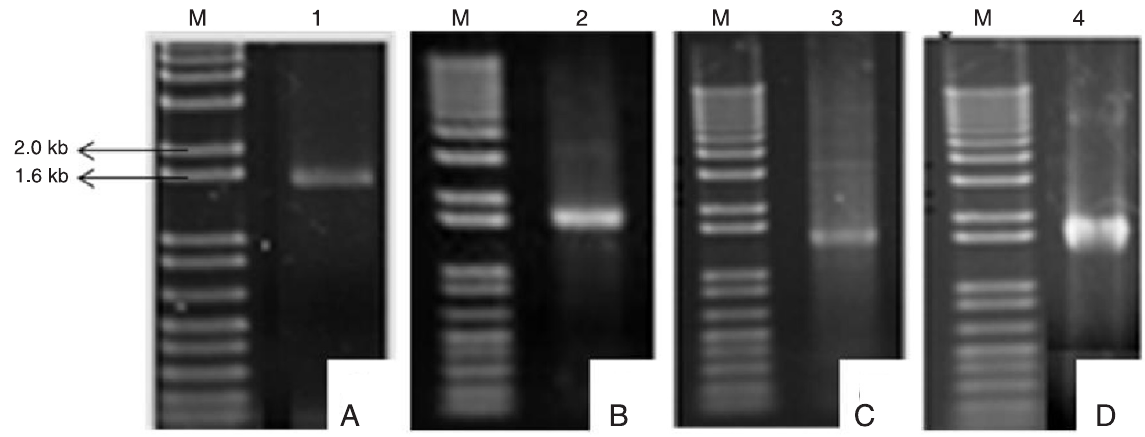
Figure 1. Confirmation of the intra- and extracellular constructs for L1 expression by PCR. A , Amplification of the HPV-16 L1 gene (1.5 kb) cloned in the pPICZα vector. B , C , and D , HPV-16 (1.5 kb), HPV-18 (1.7 kb), and HPV-33 (1.5 kb) L1 genes, respectively, cloned in the pPICZ vector. On all gels, we used the molecular weight marker 1 kb plus (lane M; Invitrogen).